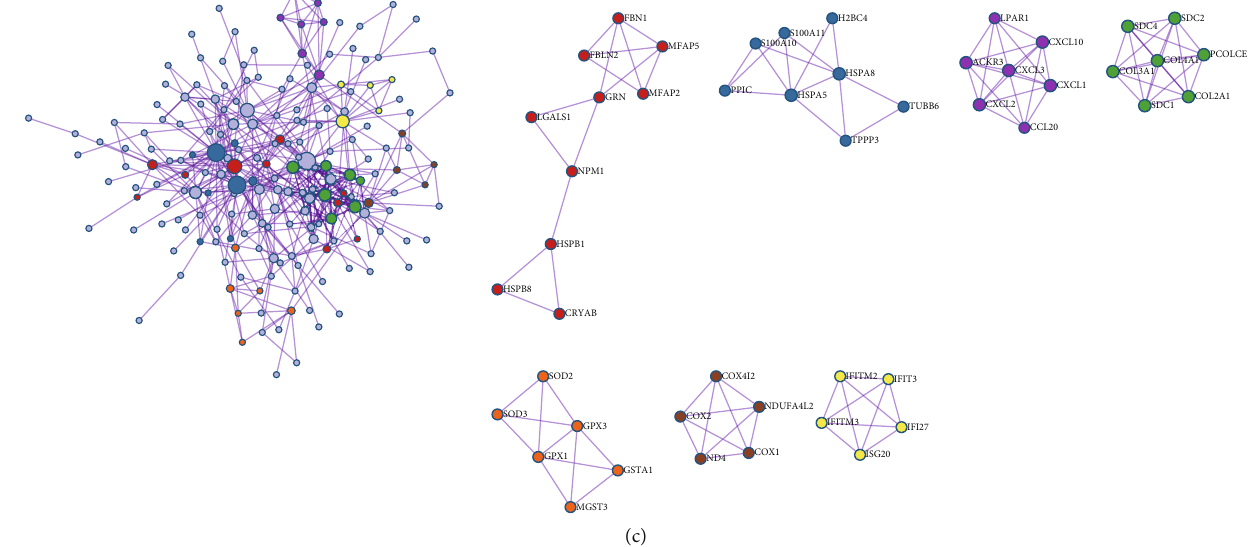
Figure 5: Network of enrichment analysis by (a) pathways and (b) P value; protein-protein interaction (PPI) network of di ff erentially expressed